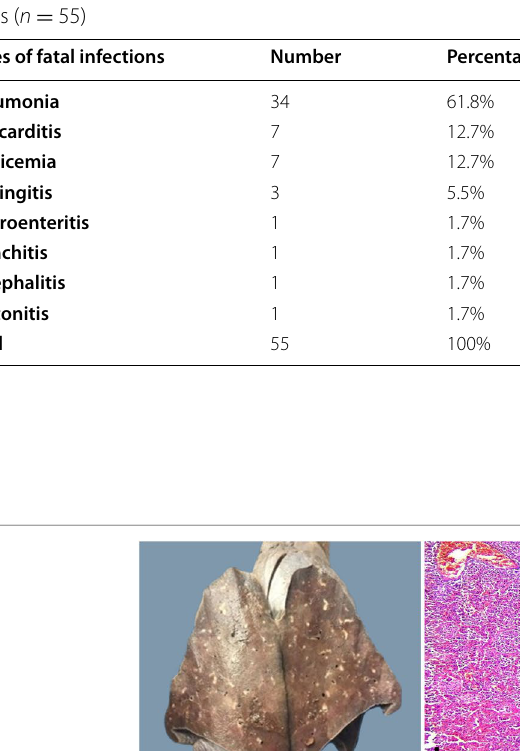
40), c dense polymorphonuclear leukocytes are ×